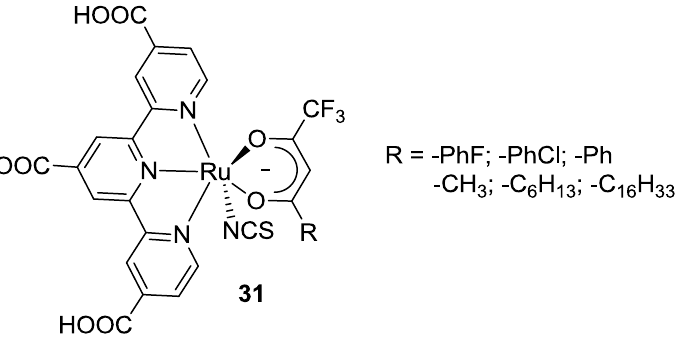
Figure 25. β-diketonates ligands by Islam et al. [119–125]. Figure 25. β -diketonates ligands by Islam et al.